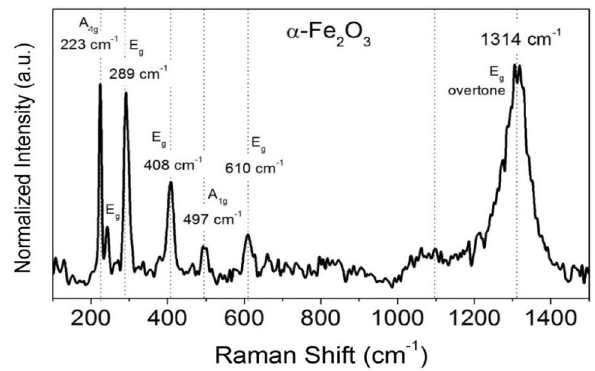
Figure 6. Raman spectrum of α-Fe 2 O 3 nanocubes.